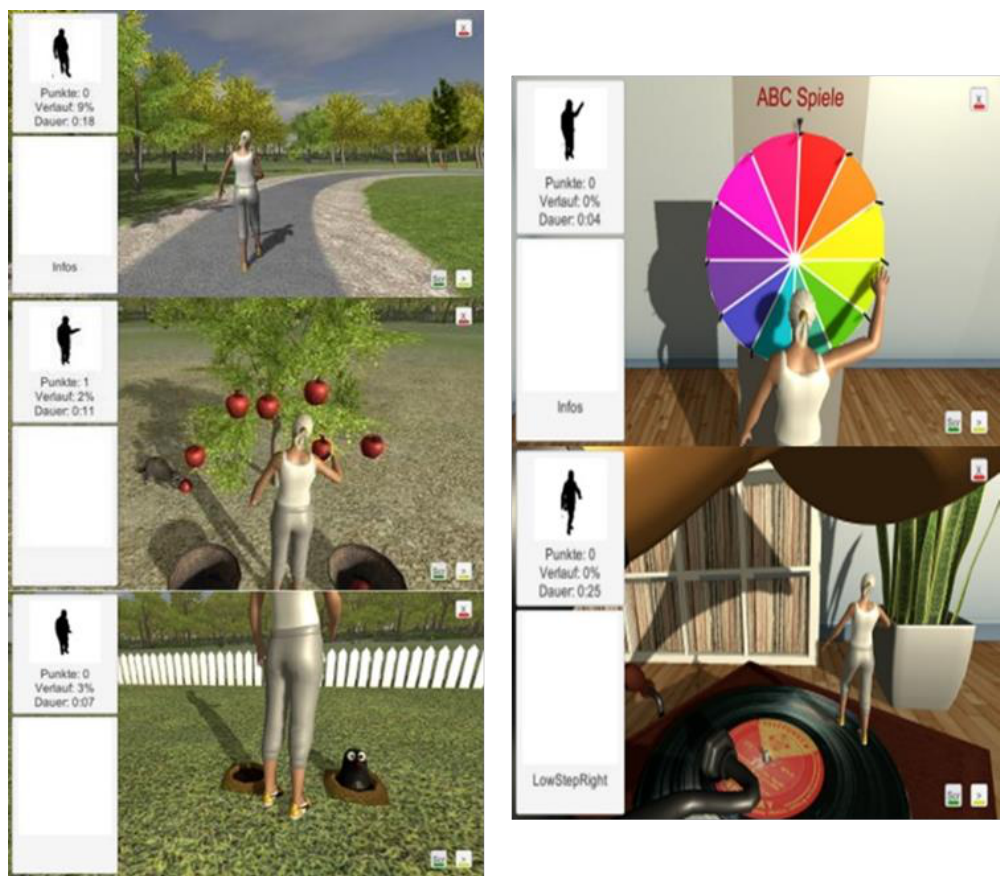
Figure 8. ( Left ) displays the strength and balance Park, Apple and Mole exergames. ( Right ) displays the Wheel of Fortune and Music/walking on the spot exergames. (Permission granted by David. Unbehaun) [64].